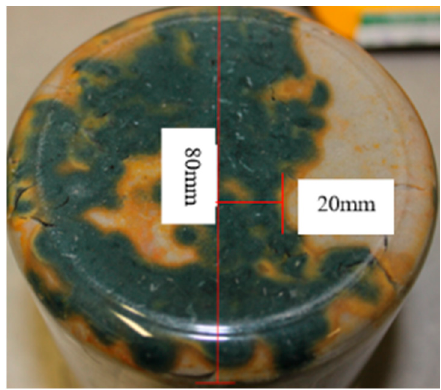
Figure 22. Development of Greenish-blue corrosion with an Orange corrosion front after 2 year.